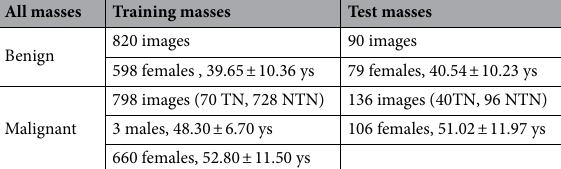
Table 2. The basic information of collected cases.